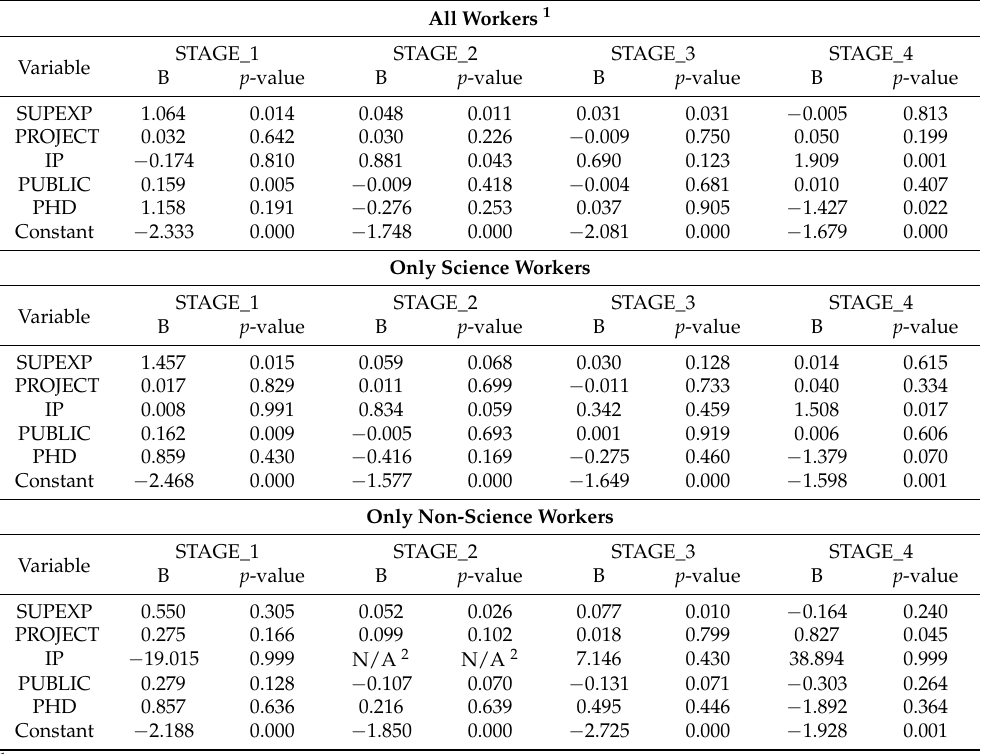
Table 4. Logistic regression models (dependent